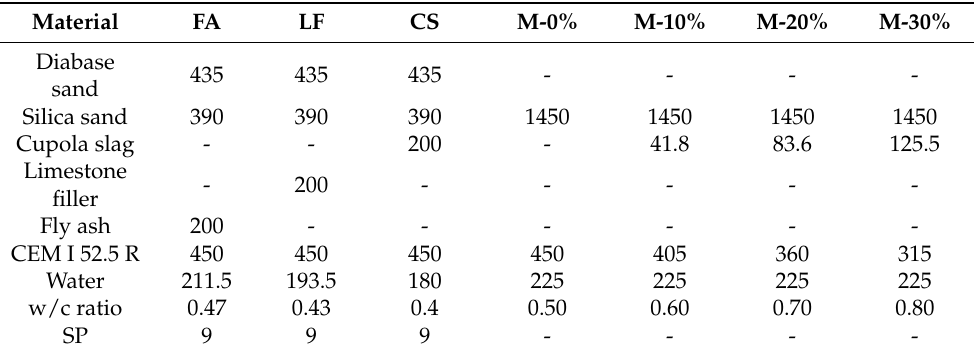
Table 4. Mix proportions of the manufactured mortars